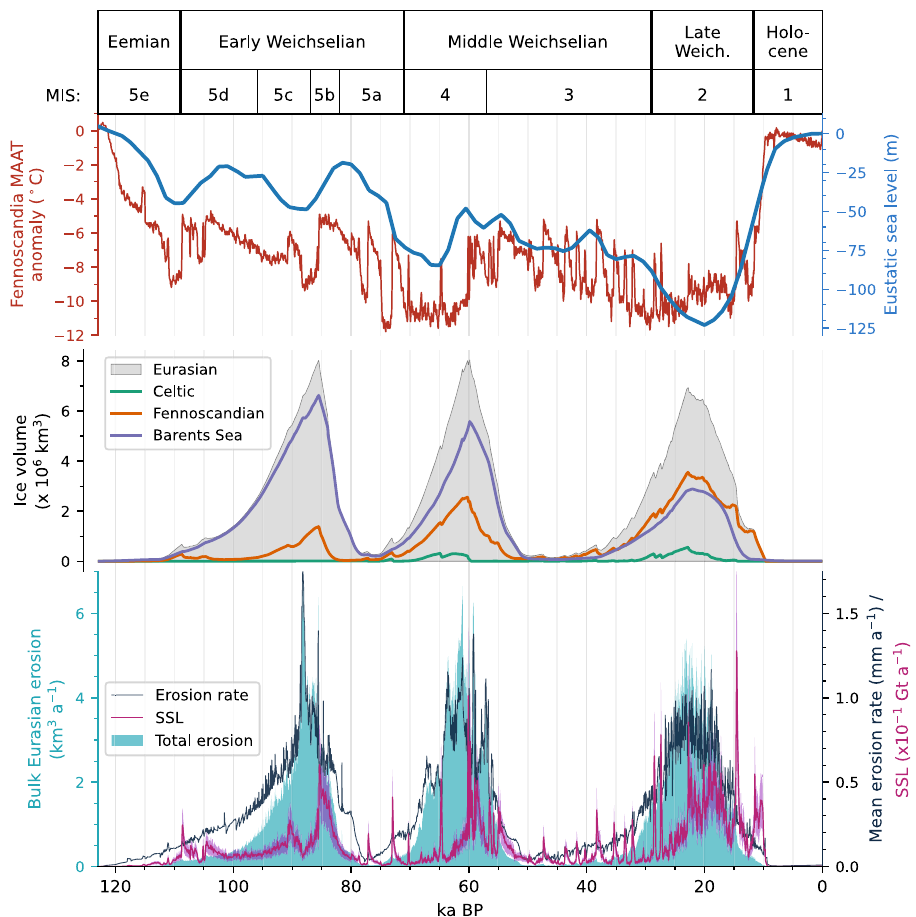
Fig. 1 | Modelled outputs of the Eurasian ice sheet over the last glacial cycle. Evolution of the climate (NGRIP 101 ) and eustatic sea level 63 forcing curves, ice